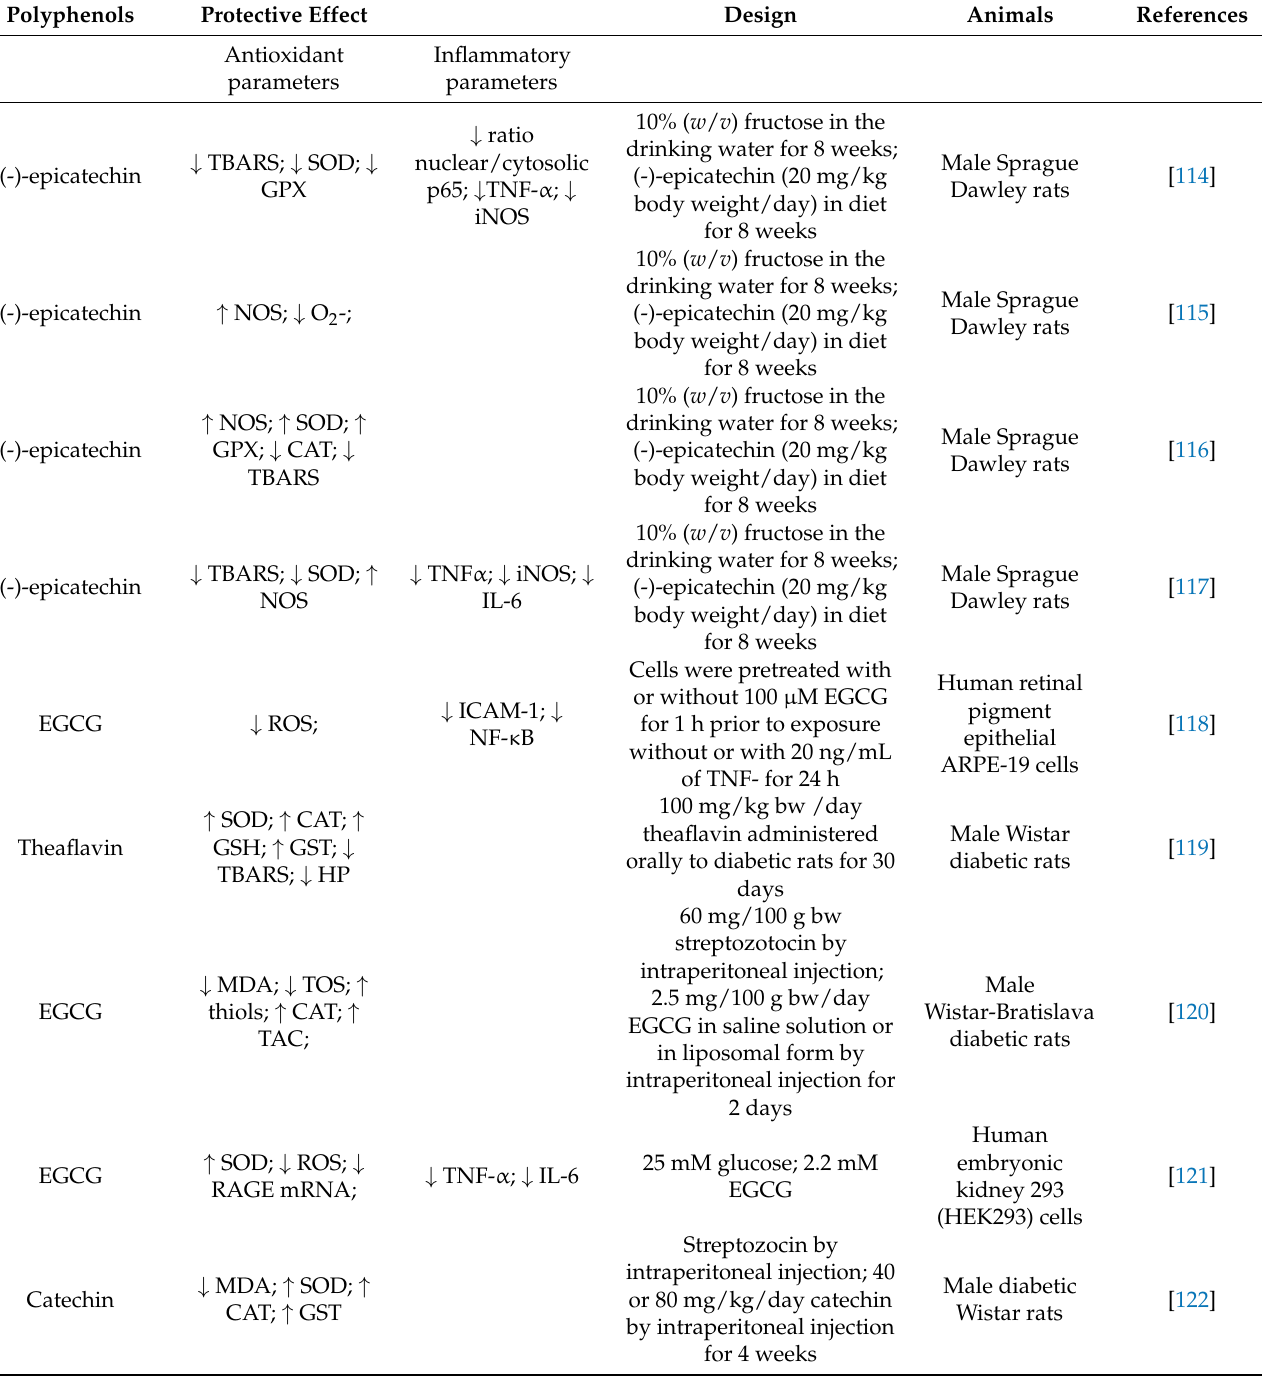
Table 1. Antioxidant and anti-inflammatory effects of tea